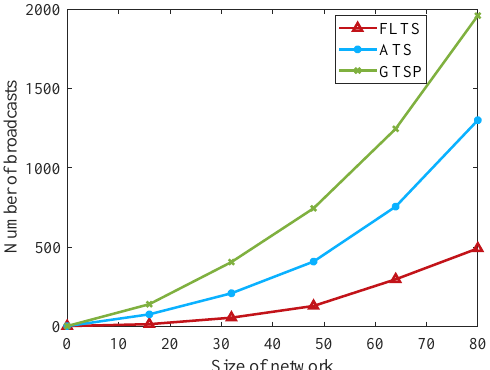
Figure 4. Comparison of communication